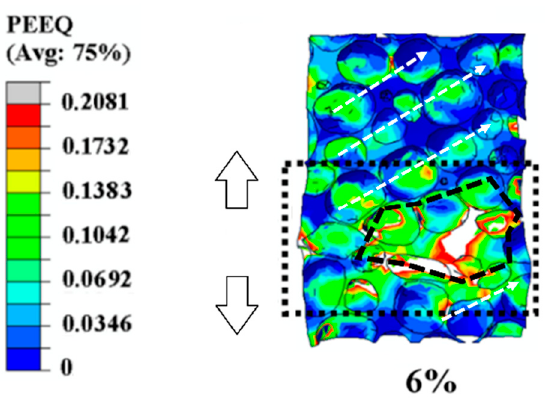
Figure 6. Illustration of the collapse band and the path of plastic strain concentration at strain level 6%. The up and down arrows on the left of the contour figure represent the overall propagation of the plastic deformation range.